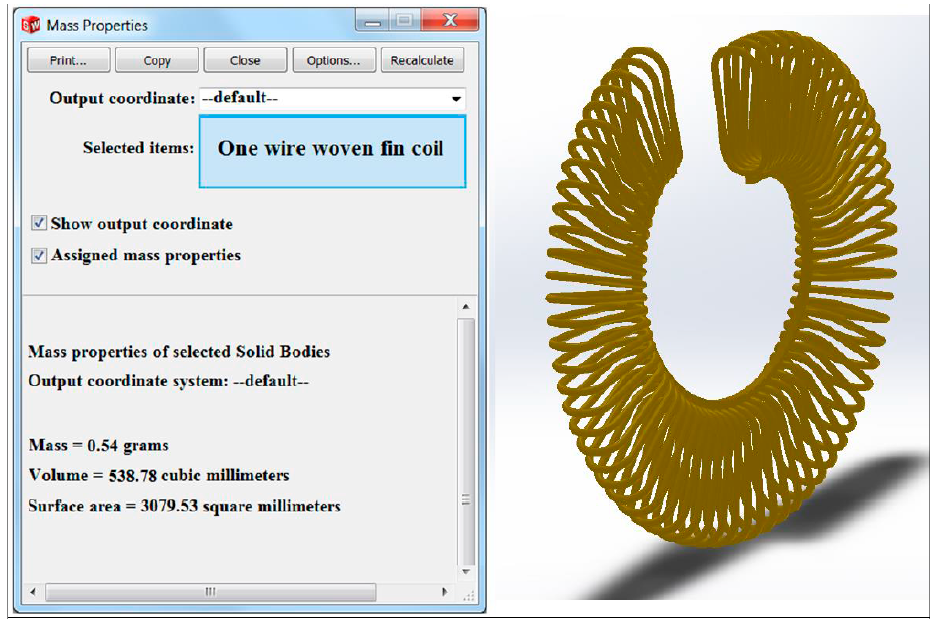
Figure 22. One wire woven fin volume and surface area generated 3D CAD model.